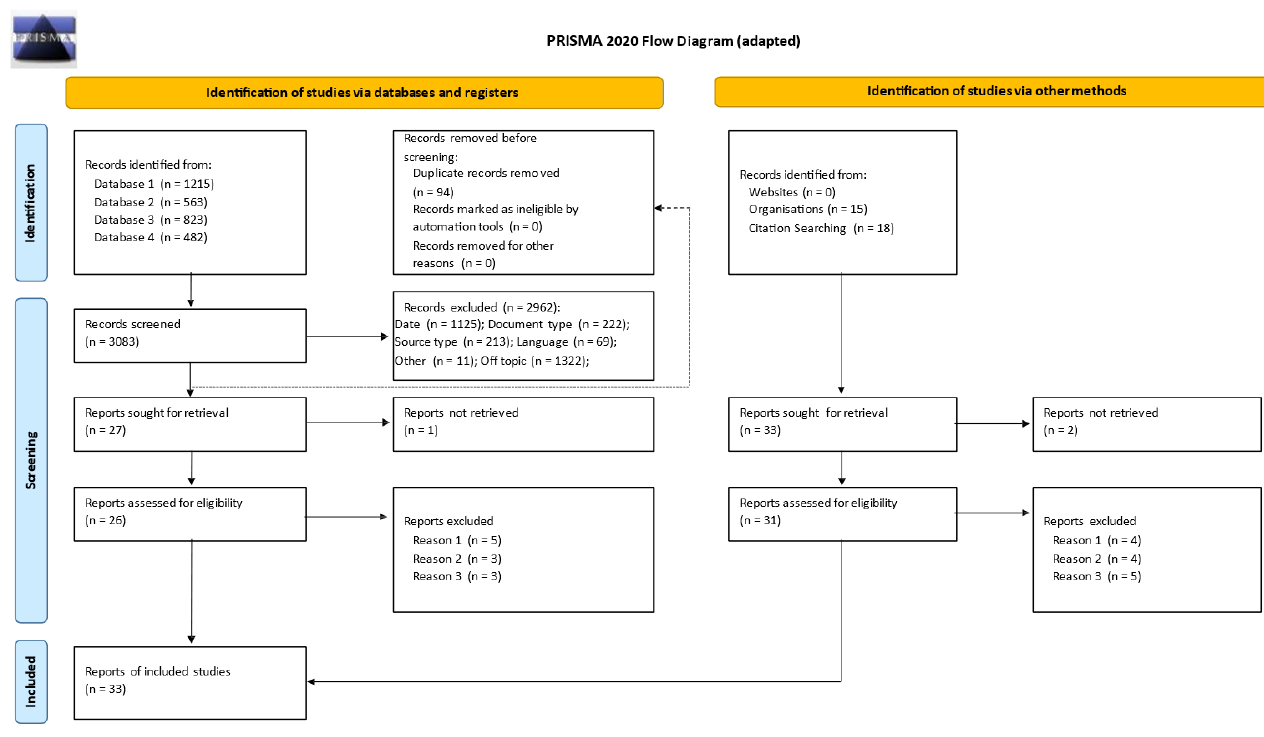
Figure A1. Summary of the charting process based on PRISMA flow diagram [15].